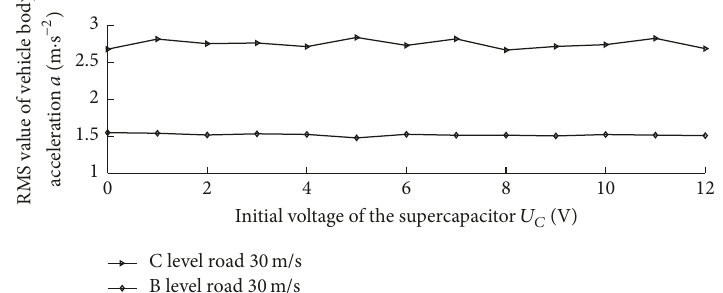
Figure 9: The relationship between vehicle body acceleration and supercapacitor initial terminal voltage.